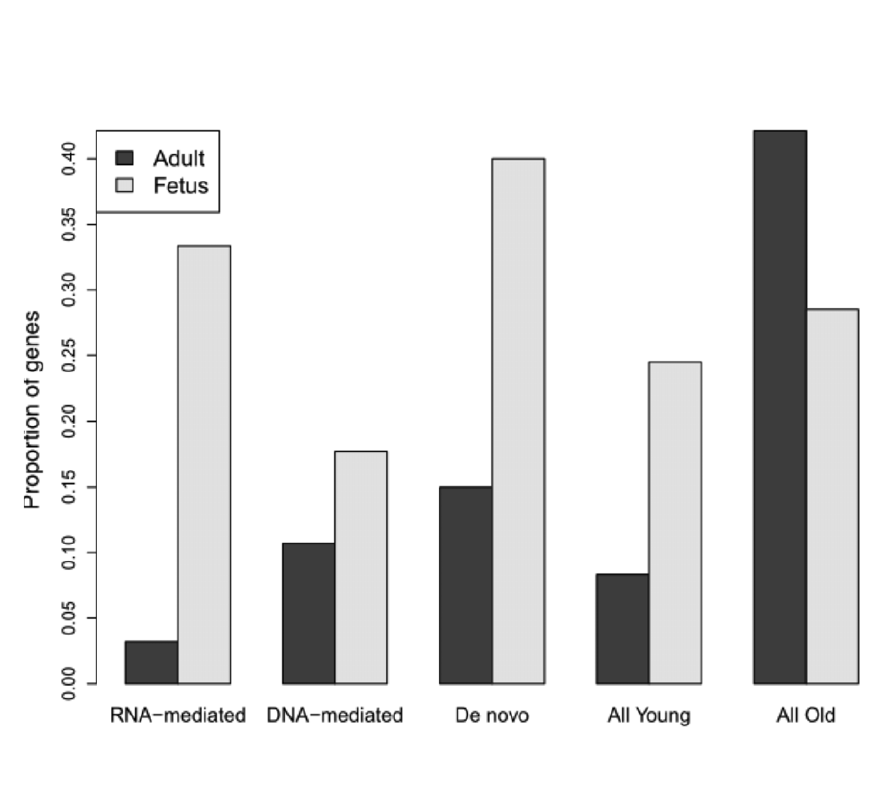
Figure 3. Origination mechanisms of genes up-regulated in the adult and fetal brain. Within each category, the barplot shows the proportion of genes up-regulated in adult brain and in fetal brain, respectively. Binomial test reveals that new genes originated by various mechanisms are significantly more frequently up-regulated in fetal brain ( p , 0.05).